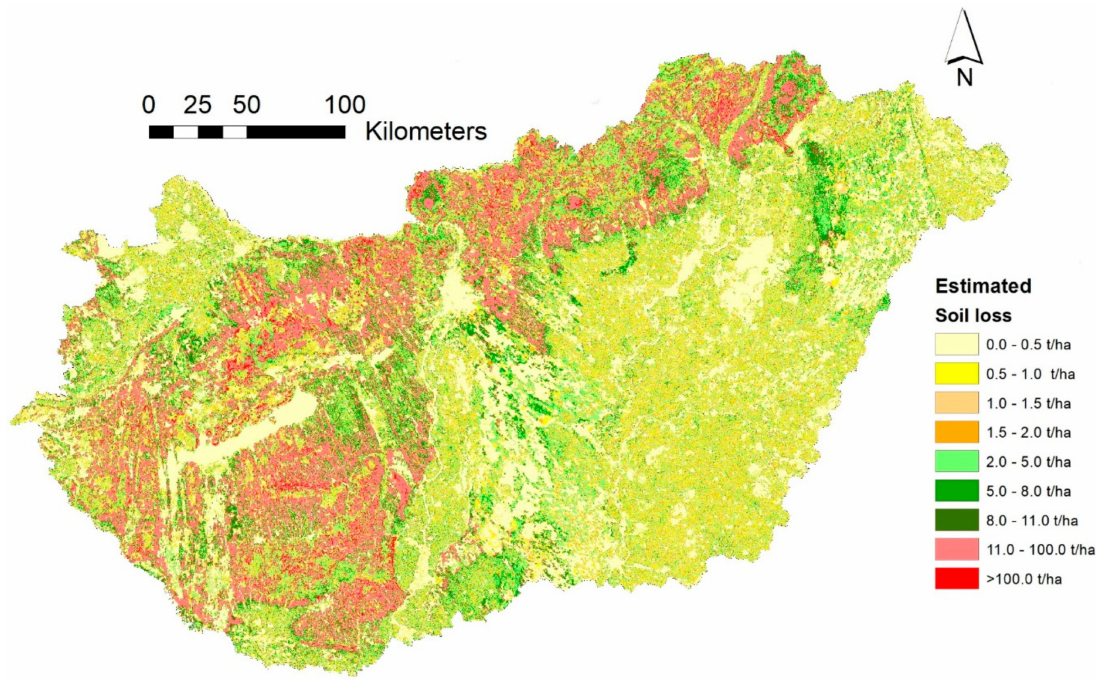
Figure 8. Estimated soil loss for 2018 LULC by the combination of the PESERA and USLE models.